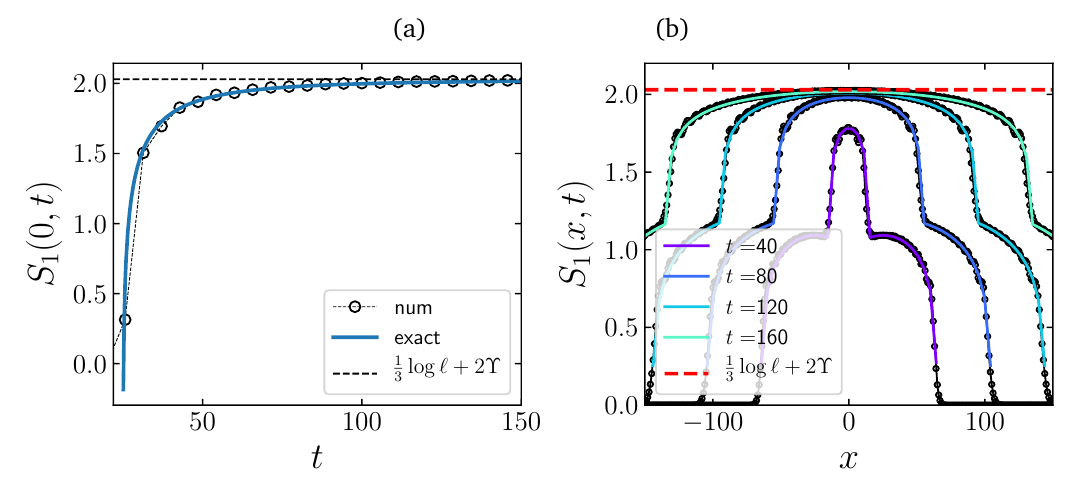
Figure 7: (a) Half-system entanglement entropy for a non-interacting spin-1 / 2 chain initially prepared in a double domain wall state (4) as function of time. The exact prediction in Eq. (49) (full-line) is compared with the numerical data (symbols) obtained for a lattice of size L = 350 with (cid:96) = 25. At times t (cid:29) (cid:96) , the half-system entanglement saturates to the constant value 1 log (cid:96) + 2 Υ (dashed horizontal line). 3 (b) Asymptotic saturation of the entanglement profiles to the value 1 log (cid:96) + 2 Υ for 3 spatial positions | x | (cid:28) t , see Eq.